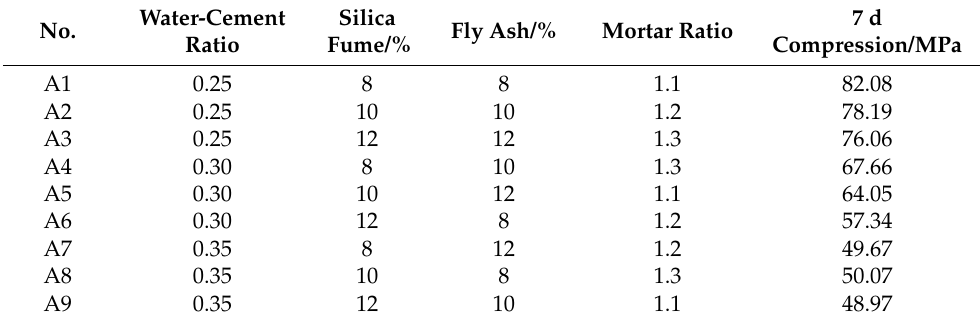
Table 7. Mix ratio of cement